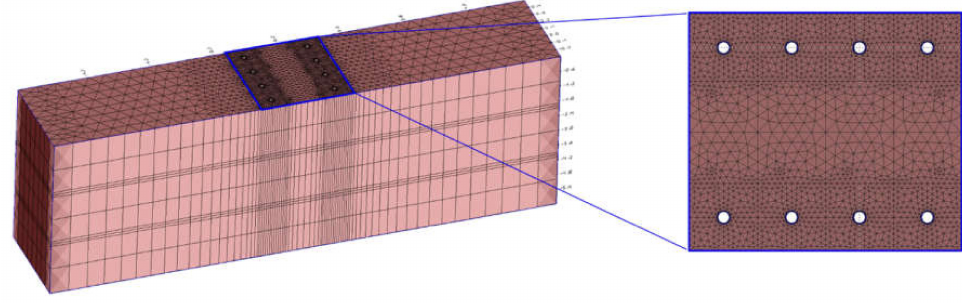
Figure 3. Mesh design of the numerical